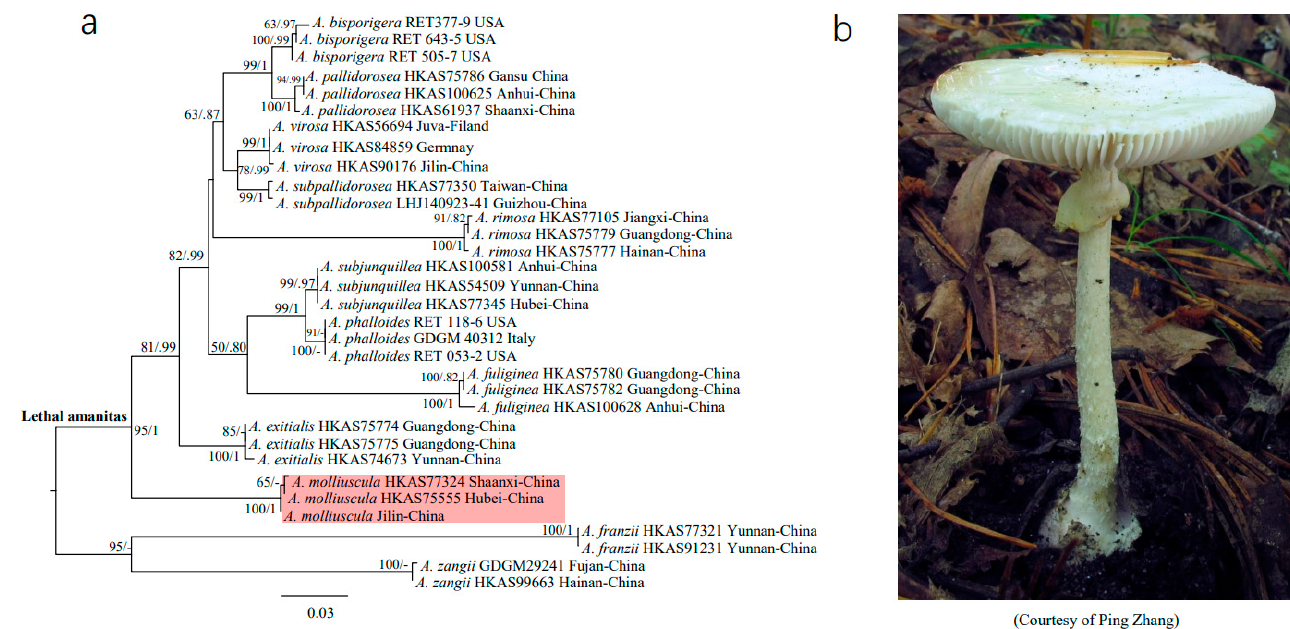
Figure 1. ( a ) Phylogenetic tree of lethal amanitas. ( b ) Amanita molliuscula in the field.